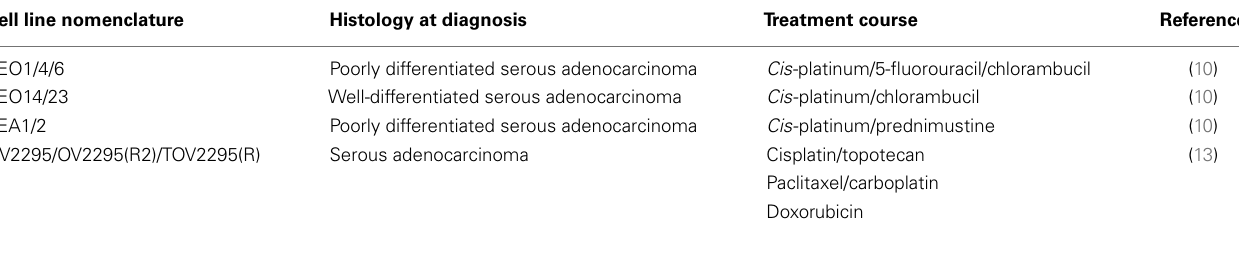
Table 1 | Clinical characteristics of paired platinum sensitive and resistant HGSOC cell lines